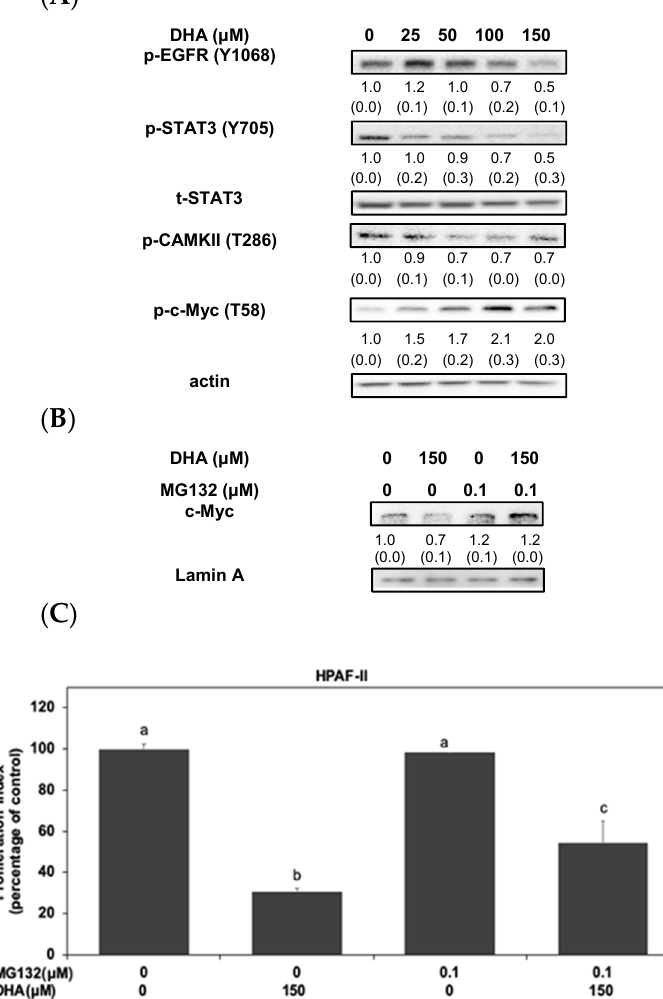
Figure 3. DHA induced the proteasomal degradation and instability of c-Myc protein in HPAF-II cells. ( A ) Human PDAC HPAF-II cells were treated with DHA in 10% FBS DMEM for 24 h. Western blotting analysis of cytoplasmic and nuclear proteins (at 24 h time point) was performed using antibodies against p-EGFR (Y1068), p-STAT3 (Y705), t-STAT3, p-CAMKII (T286), p-c-Myc (T58) and actin. Band intensities are represented as the mean ± SD (within parenthesis) for the amount of each protein in comparison with internal control actin. ( B ) Human PDAC HPAF-II cells were treated with DHA (150 µ M) in 10% FBS DMEM in the presence or absence of MG-132 in 10% FBS DMEM for 24 h. Western blotting analysis of nuclear c-Myc protein was performed using antibodies against c-Myc and lamin A. Band intensities represent as the mean ± SD (within parenthesis) for the amount of c-Myc protein in comparison with the internal control lamin A. ( C ) Human PDAC HPAF-II cells were treated with DHA in the presence or absence of MG-132 in 10% FBS DMEM for 24 h. Cell survival was analyzed using MTT assay, as described in the Materials and Methods Section. Statistical significance is expressed as the mean ± SD (standard deviation) of three independent experiments. Different letters represent statistically significant differences within different subgroups ( p <